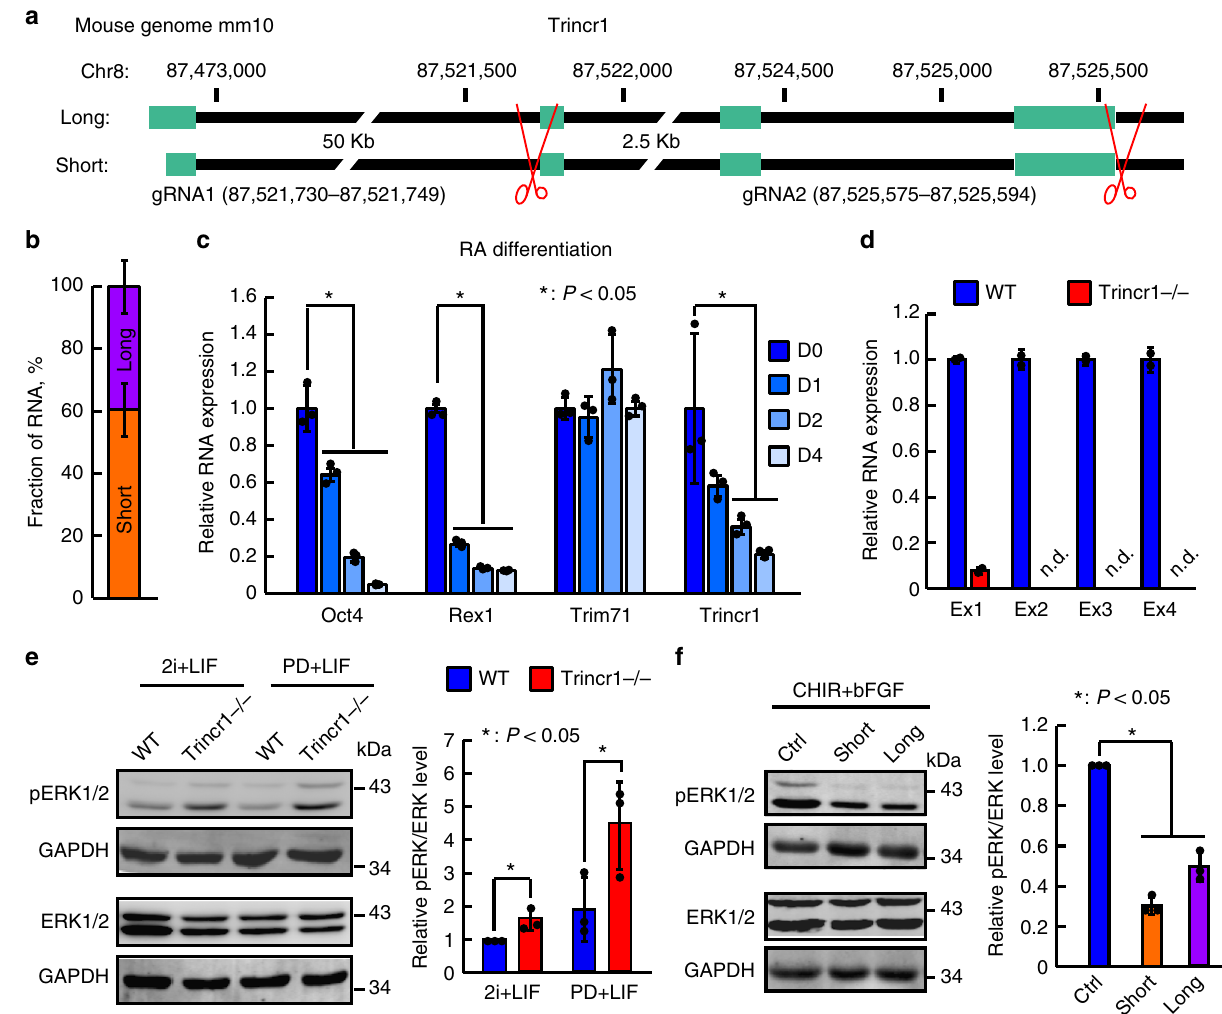
Fig. 2 Trincr1 represses FGF/ERK signaling in ESCs. a Gene structure of Trincr1_L and S. Exon 1 (L): 87,472,809 – 87,472,960; Exon 1 (S): 87,472,871 – 87,472,960; Exon 2: 87,521,736 – 87,521,813; Exon 3: 87,524,296 – 87,524,427; Exon 4: 87,525,415 – 87,525,554; Cleavage and polyadenylation signal sequence “ AAUAAA ” : 87,525,535 – 87,525,540. Scissors indicate the position of two gRNA sequences used to knockout Trincr1 in this study. b Fraction of Trincr1_L and S in ESCs. c RT-qPCR analysis of Trincr1 and Trim71 in differentiated ESCs induced by 100 nM All-Trans-Retinoic Acid for 4 days. The Gapdh gene was used as a control. For each gene, data were normalized to the RNA level of undifferentiated ESCs (day 0). n = 3 biological replicates. Appropriate differentiation is supported by the expression change of Oct4 and Rex1. d RT-qPCR analysis of Trincr1 in ESCs with Trincr1 knocked out by Cas9. Four sets of primers corresponding to four exons were used to con fi rm the loss of Trincr1 in Trincr1 − / − ESCs. The β -actin gene was used as a control. Data were normalized to wild-type ESCs. n = 2 biological replicates. e Western blotting analysis of phosphorylated ERK in wild type and Trincr1 − / − ESCs in 2i + LIF and PD + LIF. For quanti fi cation of pERK/ERK, data were normalized to GAPDH and then to wild-type ESCs cultured in 2i + LIF. n = 3 independent experiments. f Western blotting analysis of phosphorylated ERK in control and Trincr1 overexpressing ESCs induced by bFGF. For quanti fi cation of pERK/ERK, data were normalized to GAPDH and then to control overexpression vector transfected ESCs cultured in CHIR and induced by 12 ng per ml bFGF. n = 3 independent experiments. Shown are mean ± SD. For c and f , P values were determined by unpaired two-way and one-way ANOVA with two-sided Dunnett ’ s test, respectively. For e , P values were determined by paired two-sided Student ’ s t